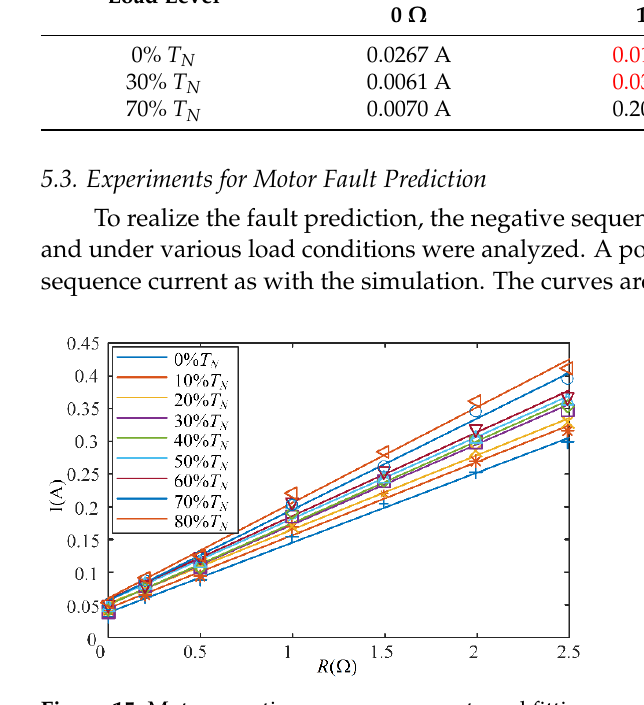
Figure 15. Motor negative sequence currents and fitting curves.